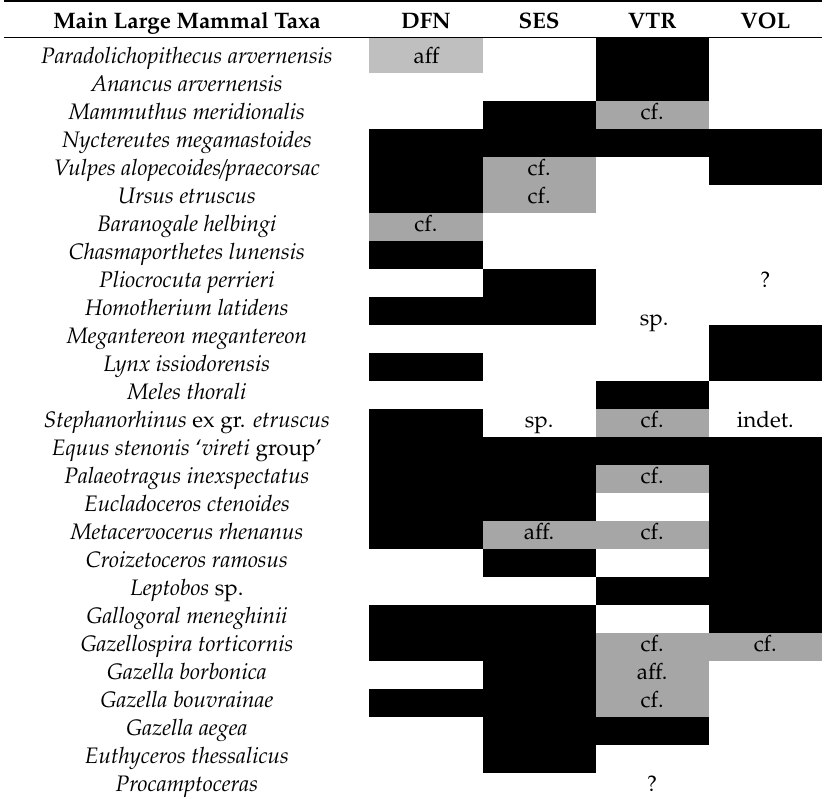
Table 2. Taxonomic comparison among several middle Villafranchian Greek large mammal faunas. Data from [48,64,65], and pers.